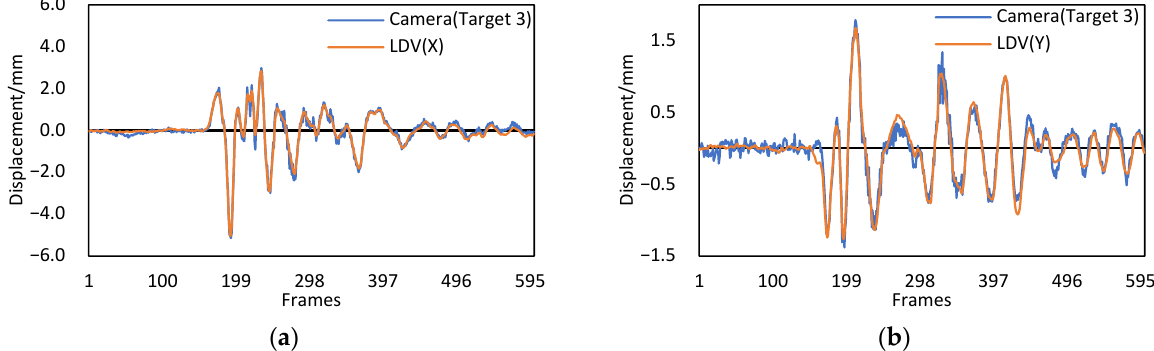
Figure 17. Comparison of the displacements with the Scheimpflug camera and LDV. ( a ) Displace- ments in the 𝑥 direction. ( b ) Displacements in the 𝑦 direction.